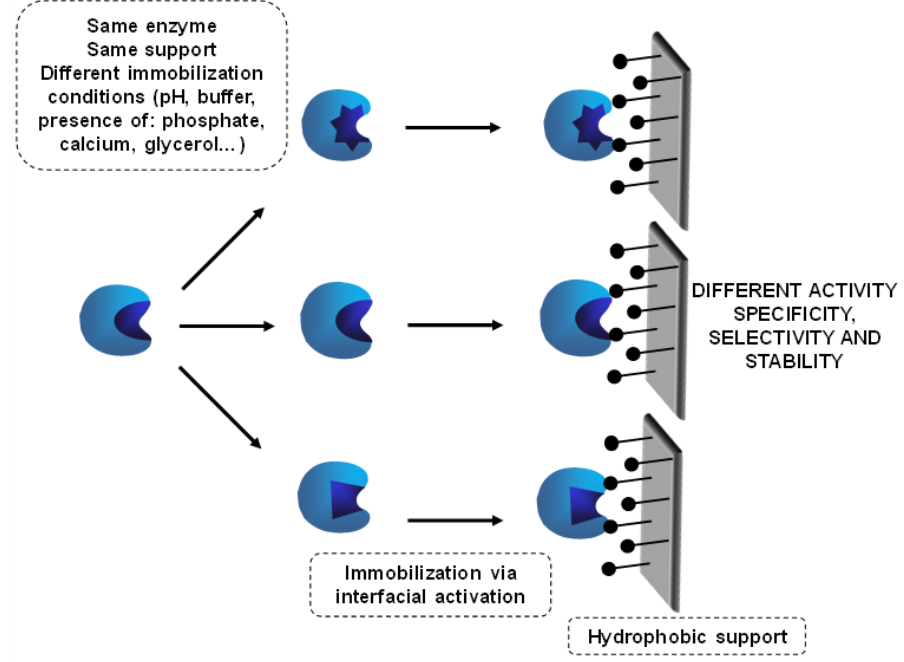
Figure 19. Effect of the immobilization conditions on hydrophobic supports on the conformation of the immobilized enzyme. Tuning enzyme activity, selectivity, specificity and stability.